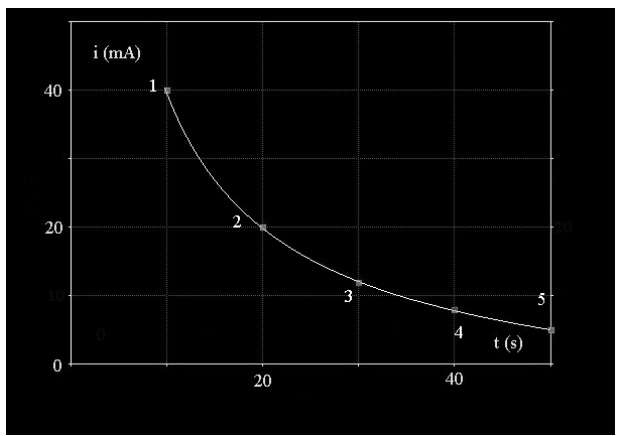
Figure 4. Current charging for hydrogen adsorption at the time of back